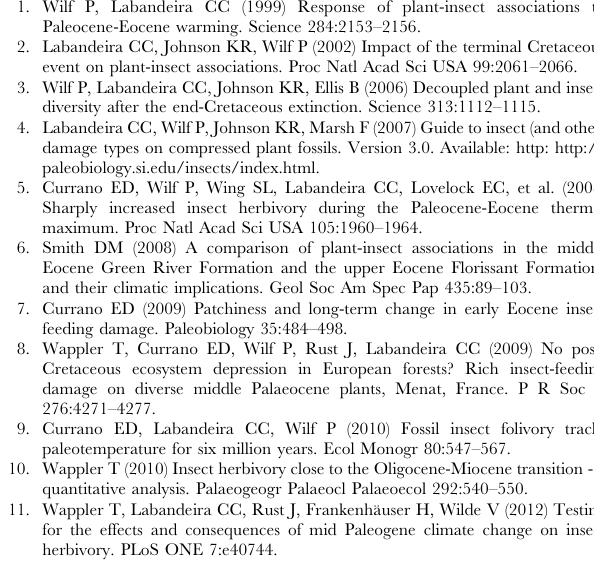
Table S3 Spearman correlation coefficients between IR and DTR at various levels, observed across 24 species of dominant trees and liana species in two Panamanian forests (See Fig. 2). Table S4 Comparisons, using Spearman’s rank-order correlation coefficients, of damage type relative abun- dances in fossil leaf assemblages and the observed numbers of culprit species corresponding to damage